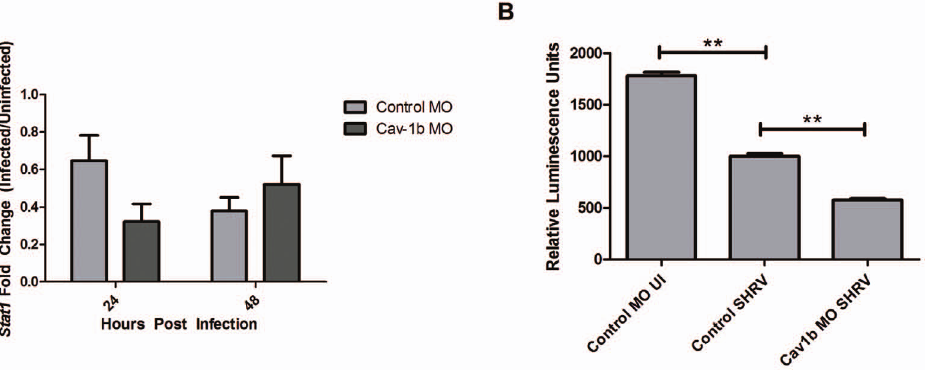
Figure 3. Decrease of Cav-1b expression negatively affects the IFN pathway. A) Stat1 gene expression was assessed by qRT-PCR in Control MO and Cav-1b MO embryos that were either SHRV infected or uninfected. Total RNA was extracted from 10 fish per treatment, cDNA synthesized and Stat1 mRNA expression assessed by qRT-PCR 24 hpi. The data are representative of three individual experiments and error bars indicate SEM. Each bar represents the mean fold induction of SHRV-infected embryos over corresponding controls. All expression values were normalized to zebrafish 18s. B) ISRE promoter activity is dampened in Cav-1b knockdown ZFL cells upon SHRV infection. ZFL cells were transfected with 250 ng of zISRE-luc construct along with 250 ng of cav-1b MO or control MO. Twenty four hours post transfection the ZFL cells were infected with SHRV at an MOI of 0.01. Cells were harvested for luciferase measurements 24 hpi. The graph shows relative luminescence units of control uninfected cells compared to cav-1b MO or control infected cells. Error bars are representative of SEM for two experiments. (**, p , 0.001).